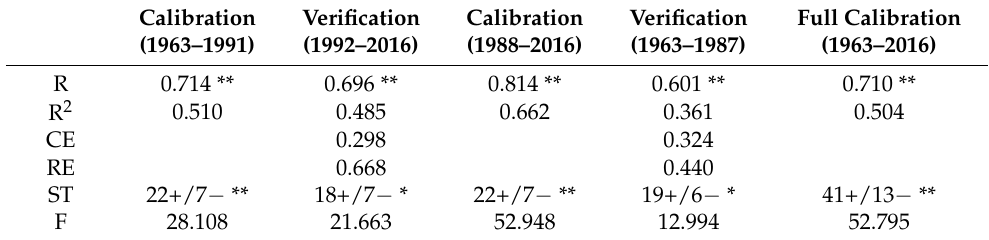
Table 2. Calibration and verification statistics for reconstructed scPDSI MJ .